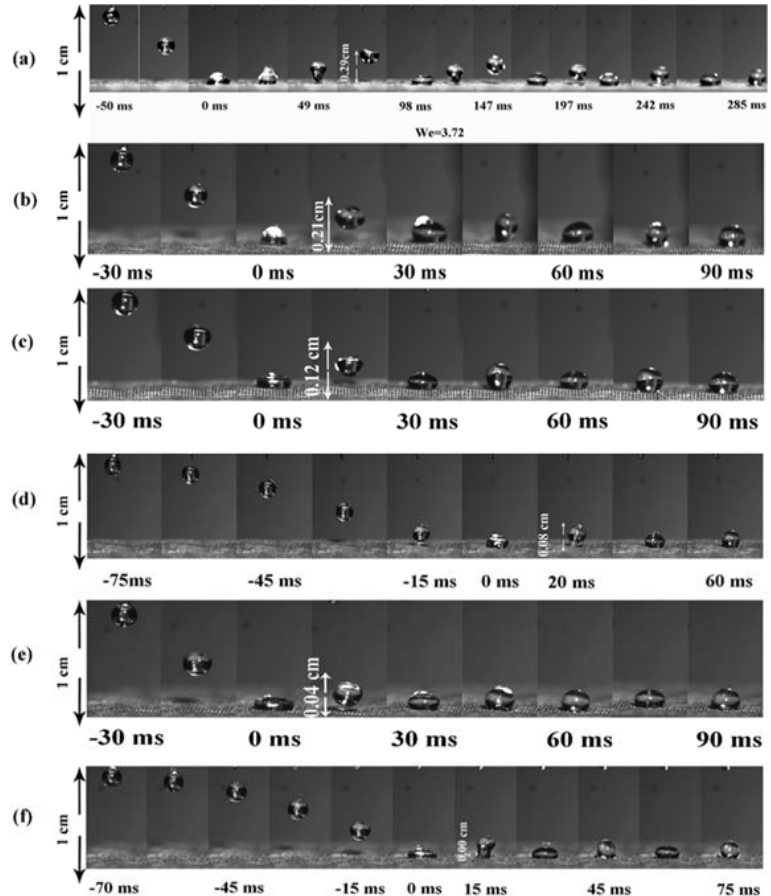
Figure 5. Snapshots of 10 μ L TTAB liquid droplets ( a – f ) with a concentration of 0, 0.5 mM, 1.25 mM, 2 mM, 4 mM, and 6 mM after impinging on the superhydrophobic surface from a constant height of 1 cm.